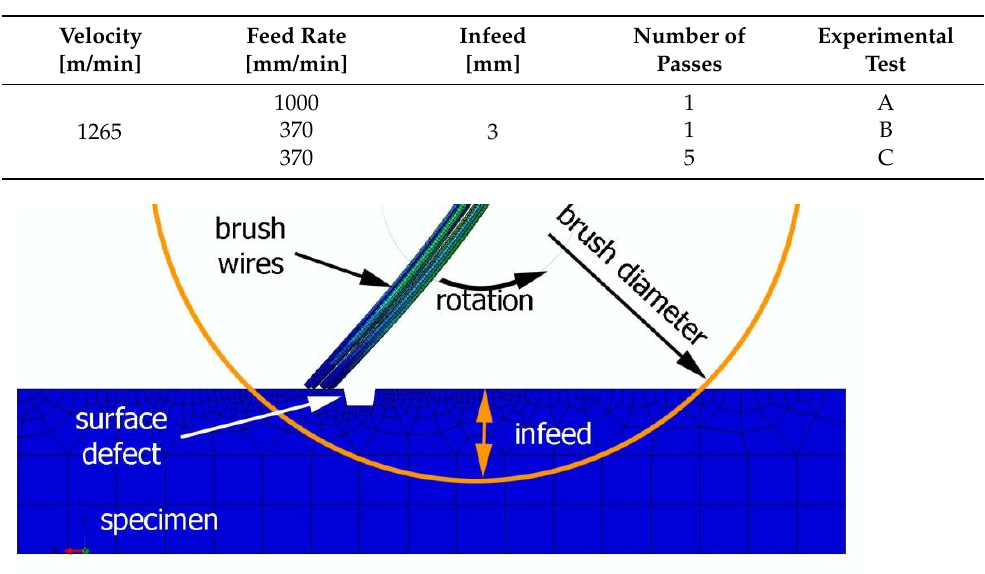
Table 3. Technological parameters of brushing.